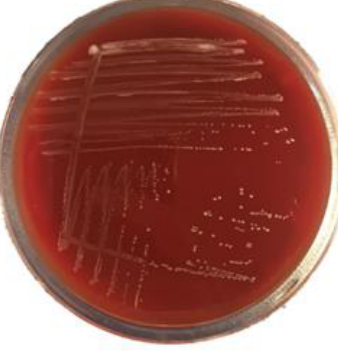
Figure 4. Hemolytic activity of P. pentosaceus BalaMMB-P3.